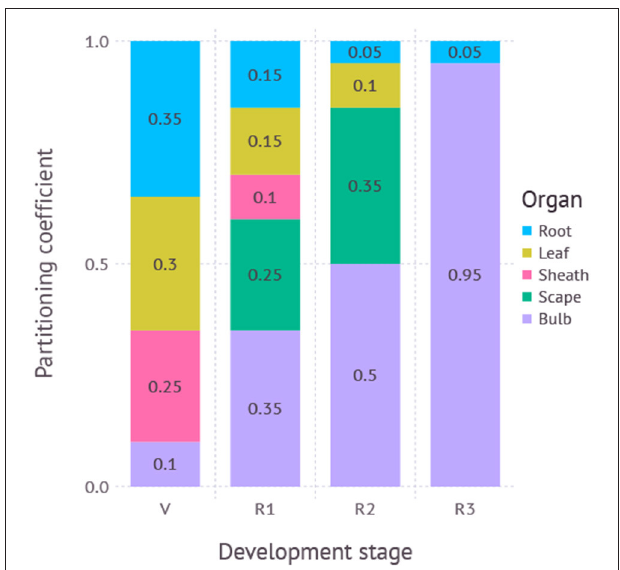
FIGURE 2 | Partitioning coefficients for plant organs dynamically adjusted according to developmental stage. V, vegetative stage; R1, reproductive stage between scape initiation and appearance; R2, reproductive stage between scape appearance and removal; R3, reproductive stage after scape removal. R3 is not used if the scape is not removed during simulation.